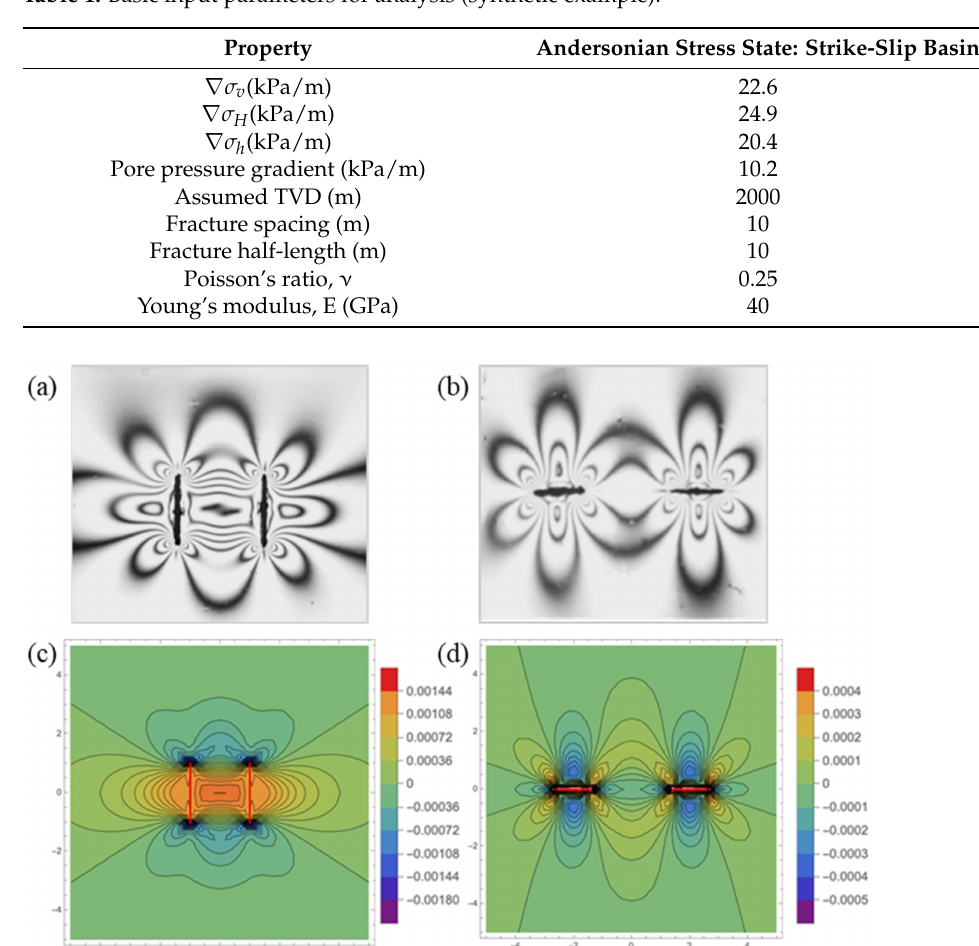
Table 1. Basic input parameters for analysis (synthetic example).